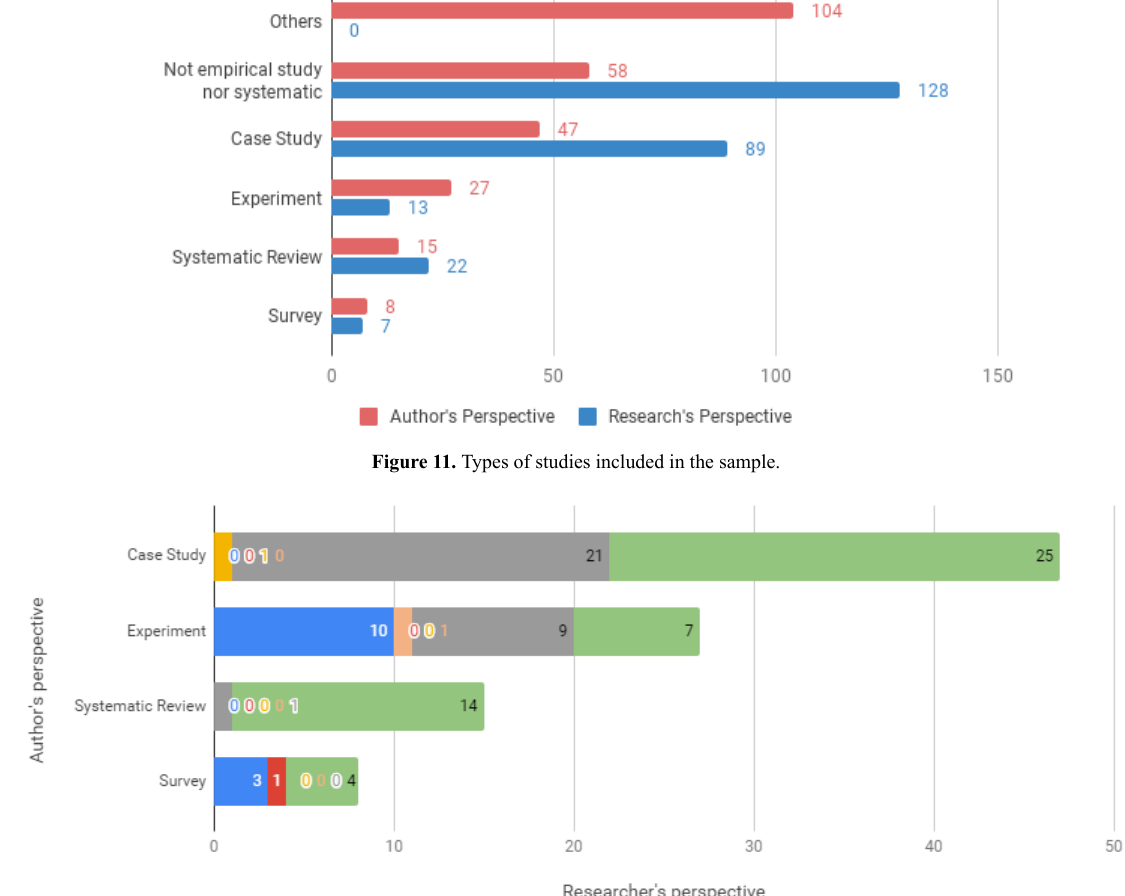
Figure 12. Comparison between author’s and researcher’s study